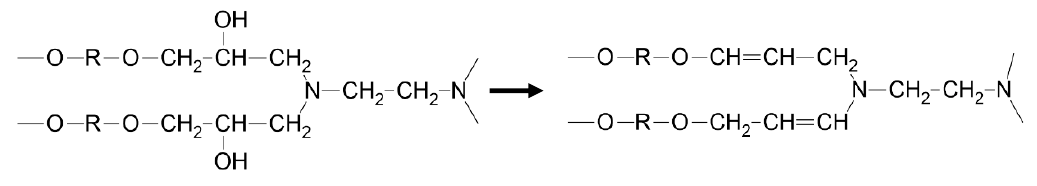
Figure 1. Models of amine addition to form secondary ( a ) and tertiary amine ( b ). Etherification is depicted in ( c ). Figure 2. The dehydration model inferred by Grassie et al. [3].